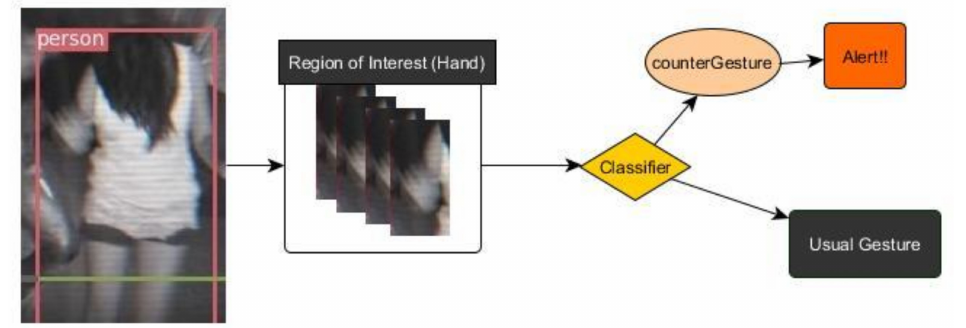
Figure 8. Considering the simplified chart, from left to right, we see how our model extracts the region of interest, processes the cropped images and classifies the gesture using the classifier. Nevertheless, the counterGesture integrated into the classifier block will trigger the alert if the specific gesture is identified three